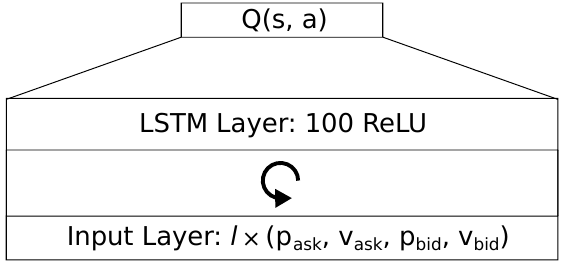
Figure 2. Our LSTM